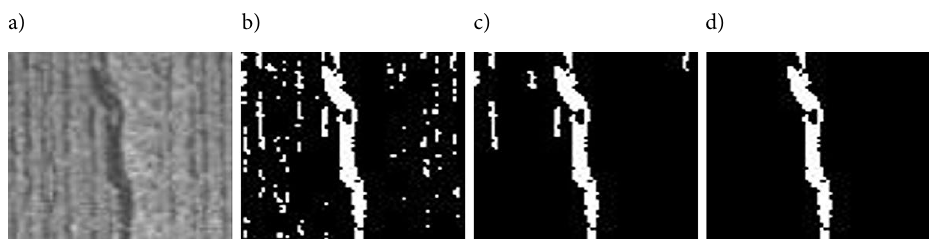
Figure 4. An example of PCrC extraction: a – RawBlock ( i ) ; b – FliterBlock ( i ) ; c – MajorBlock ( i ) ; d – MaxBlock ( i )